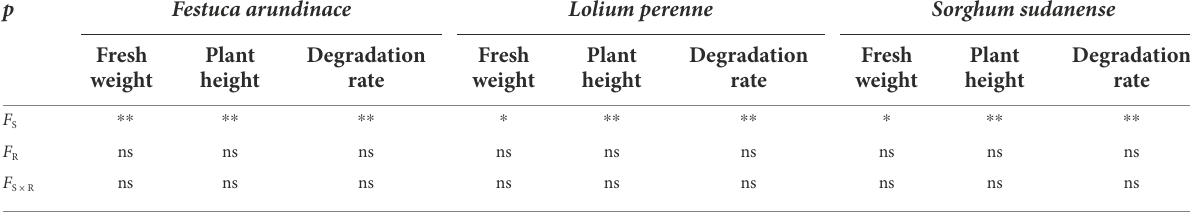
TABLE 7 Analysis of effects of soil types, root exudate types and their interaction on plant indicators.